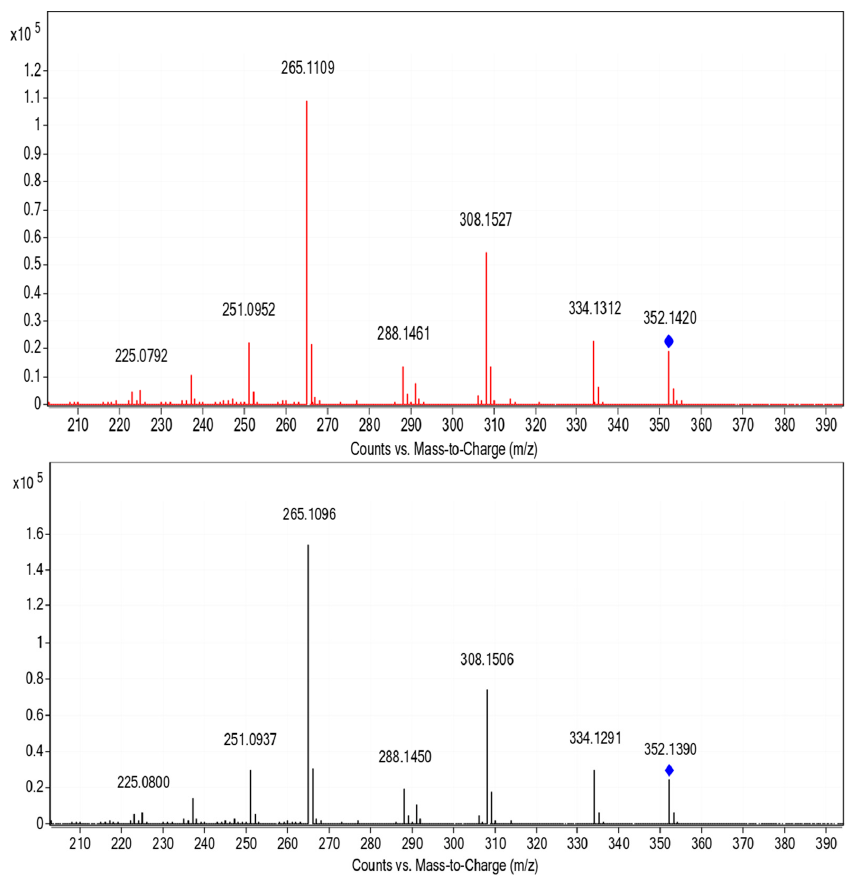
Figure 3. MS / MS spectra of the quasi molecular ion from LOM dissolved in MilliQ-water (bottom) and from samples of the River Erft (top).